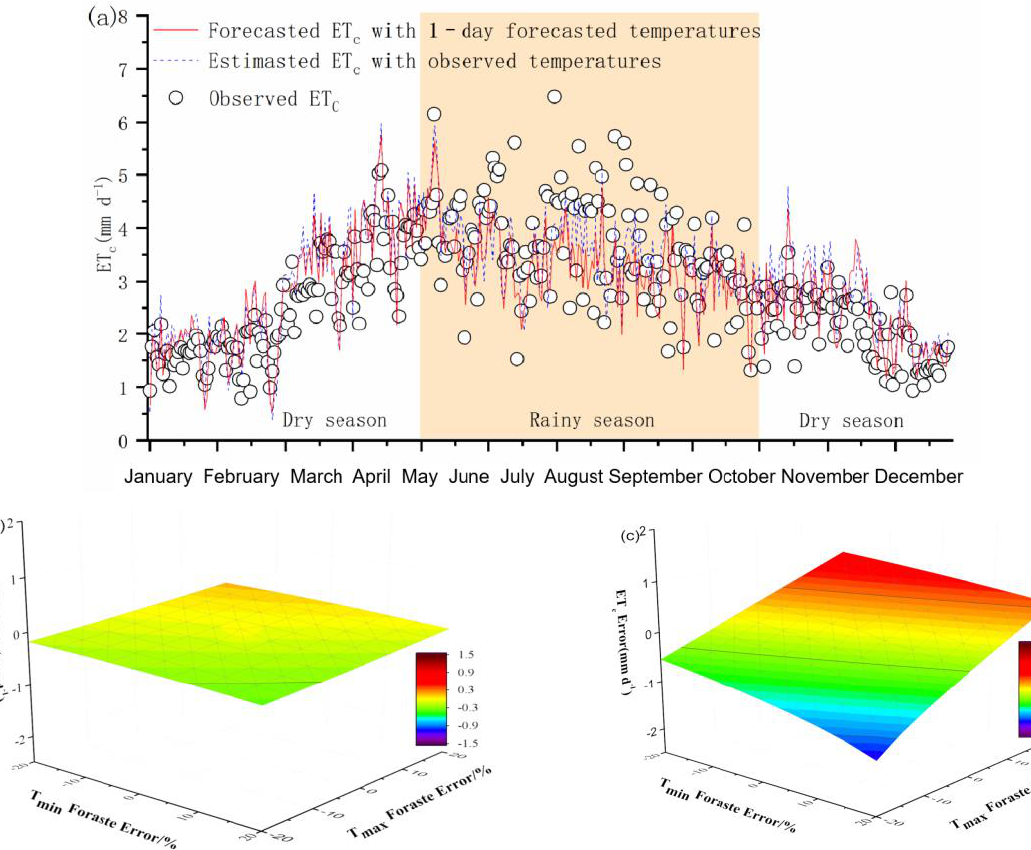
Figure 8. ET c , for for 1-, 4-, and 7-day forecasts and daily observed ET c values. Figure 8. ET c,for for 1−, 4−, and 7− -day forecasts and daily observed ET c values.